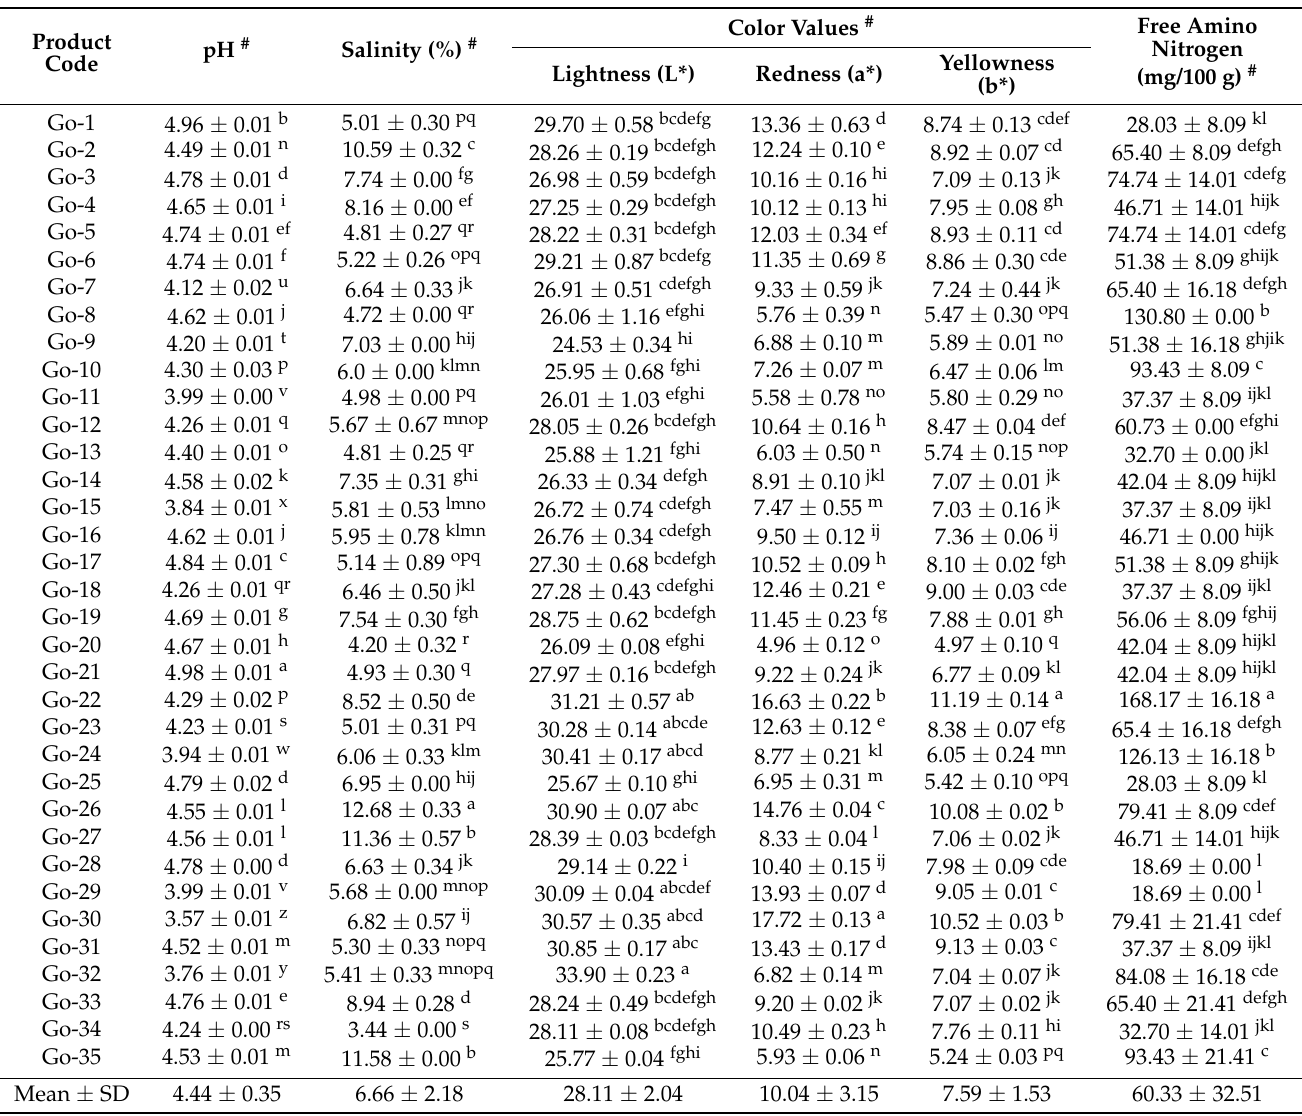
Table 1. The pH, salinity, color values, and free amino nitrogen content of gochujang